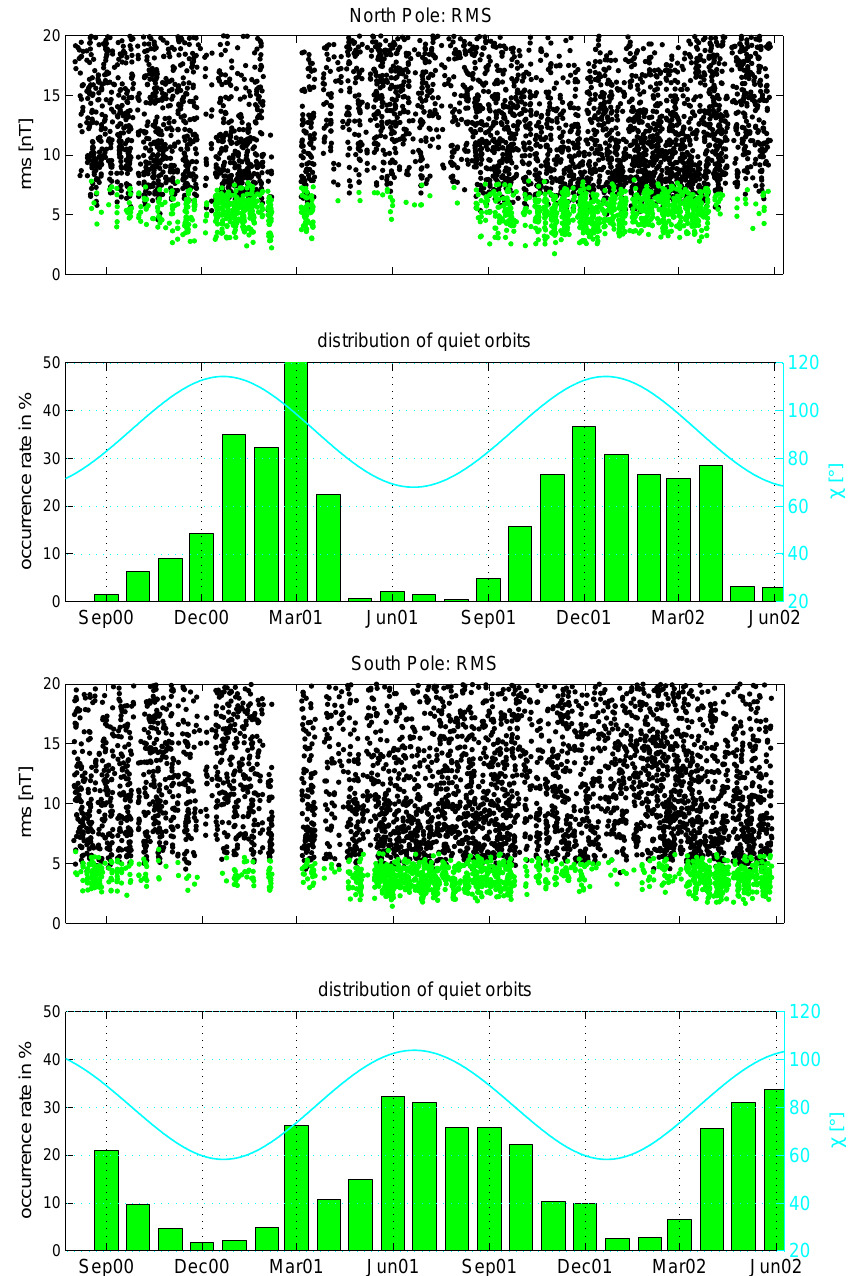
Fig. 1. Top panel: Disturbance level of the polar regions versus time. The green dots mark the low values assigned for the very quiet passes. Lower panel: occurrence of quiet passes and variation of solar zenith angle at the geomagnetic poles ( θ,φ = 81 . 8 ◦ , − 82 . 5 ◦ and − 74 . 3 ◦ , 125 . 5 ◦ ). At zenith angles of less than 80 ◦ almost no quiet events are encountered (the results of March 2001 are biased due to a large data